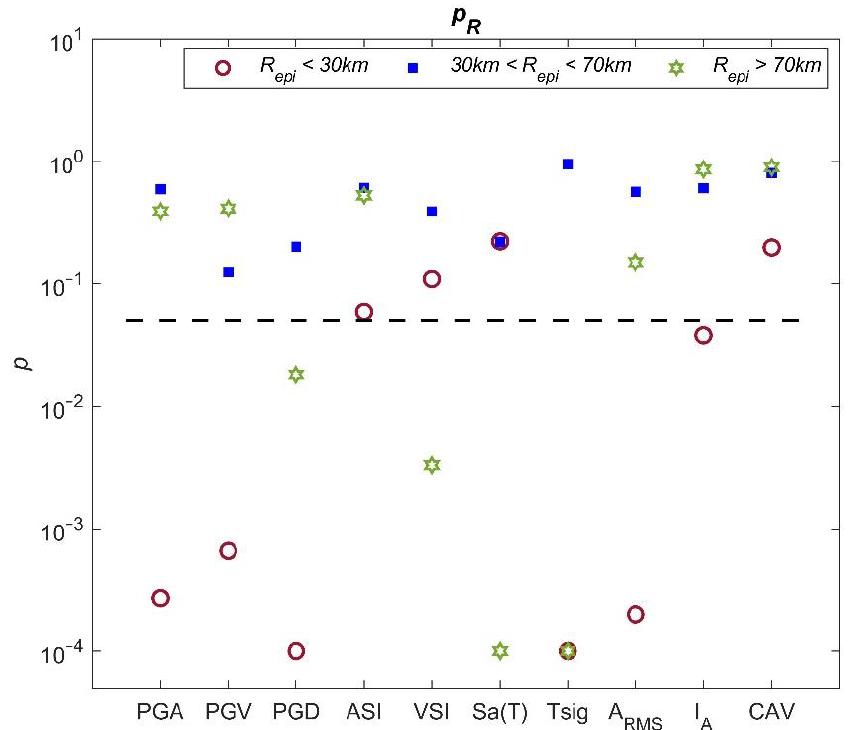
Figure 14. p values with respect to epicentral distance segregated into bins. When grouped into distance bins, most IMs show sufficiency with respect to epicentral distance for R epi > 30 km.